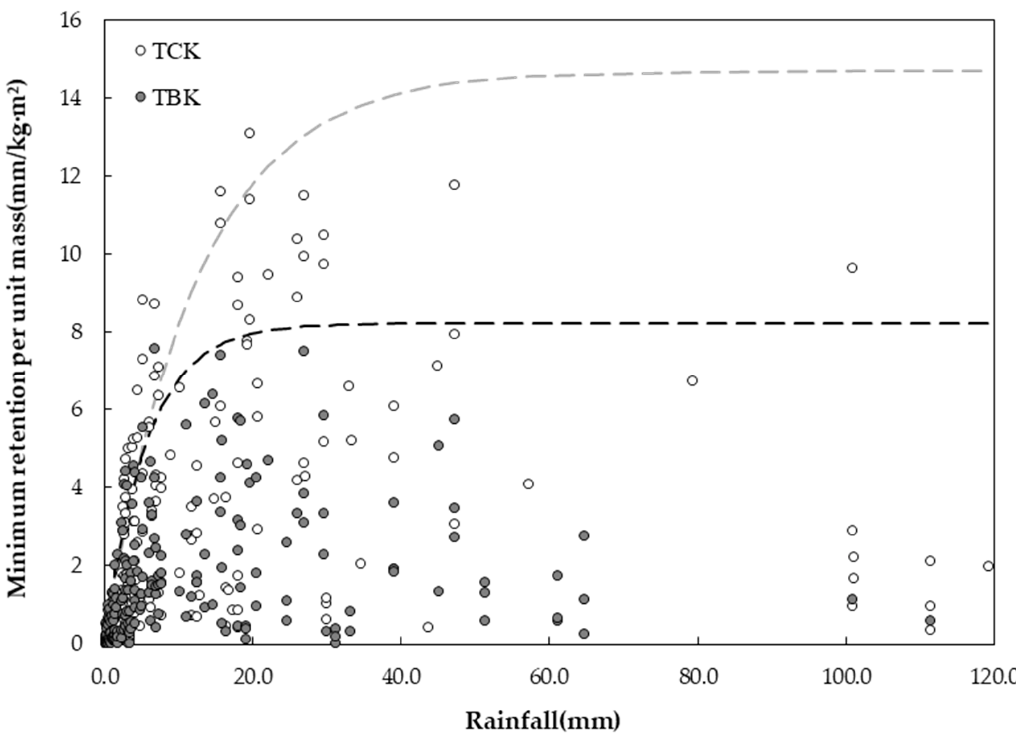
Figure 4. Variation in minimum water retention with rainfall and the corresponding envelope curve.